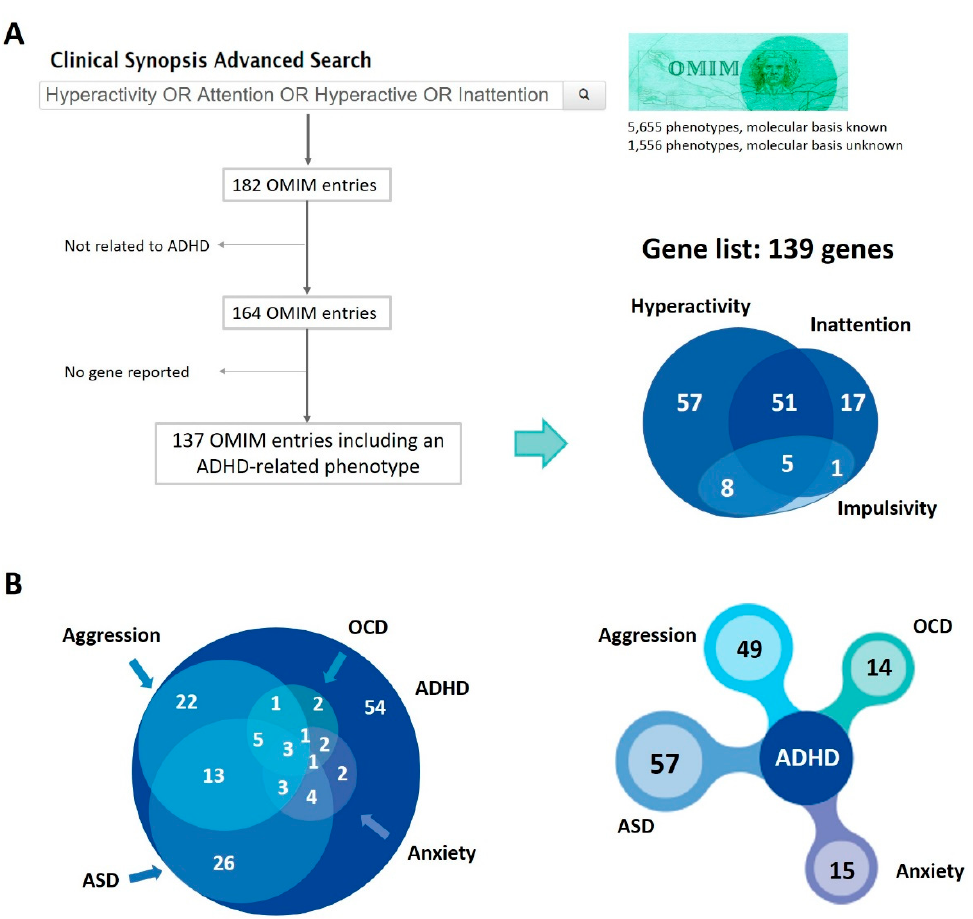
Figure 1. Mendelian disorders with a causal gene identified that present with ADHD symptoms. ( A ) Search in OMIM database (https://www.omim.org/; 25 February 2019) and selection, obtaining 137 disorders with a known causal gene and 139 genes related to hyperactivity and/or inattention, 14 of which also related to impulsivity symptoms. ( B ) Genes responsible for disorders that also present with other comorbid psychiatric conditions, considering the overlap between them (on the left) or only the comorbidity (on the right). ADHD: Attention-deficit hyperactivity disorder; ASD: Autism spectrum disorder; OCD: Obsessive-compulsive disorder. From the 139 genes described in the figure, 112 were located in autosomal chromosomes.